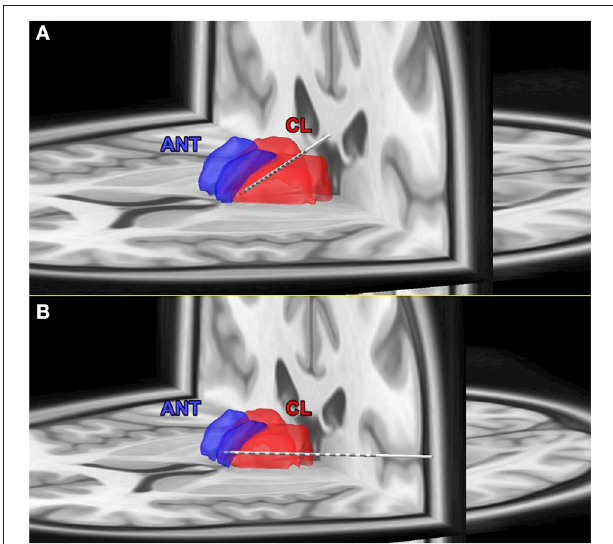
FIGURE 4 | (A) Coregistration of post-implant CT scan on pre-implant MRI and Morel’s thalamic atlas to determine the exact localization of thalamic targets. (A) An example of the electrode localized to the central thalamic nucleus (CL). (B) An example of the electrode localized to the anterior thalamic nucleus